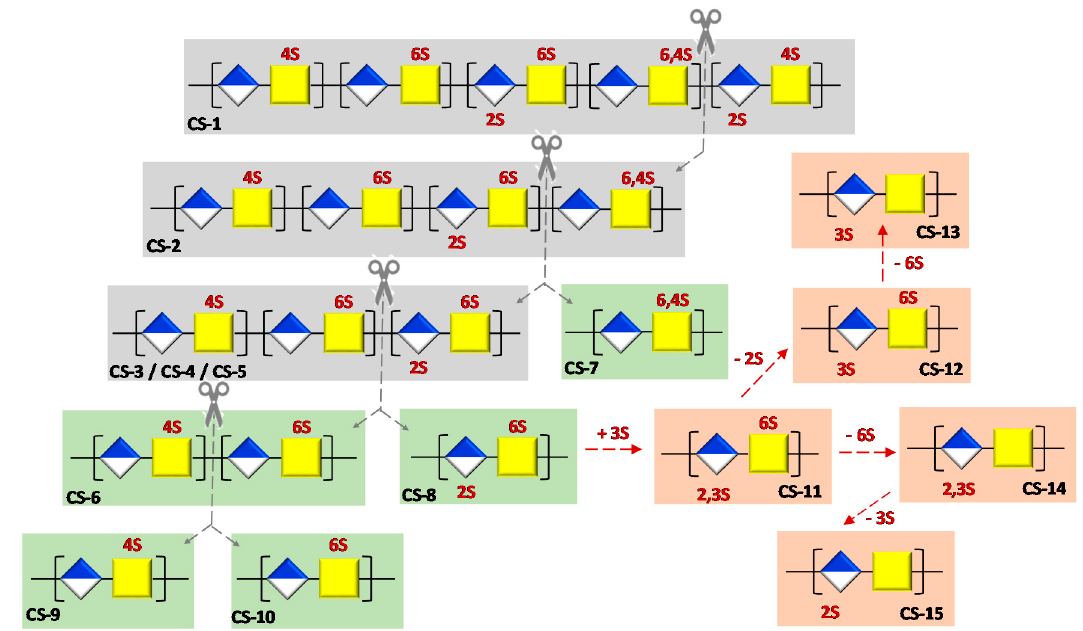
Figure 5. Schematic representation of the polysaccharides systematically analyzed in this study. Natural CSs are highlighted with a grey background. The grey dashed lines indicate differences in terms of disaccharide motifs among natural CSs. These motifs were isolated in the polysaccharides that are highlighted with a green background. Finally, a red background indicates polysaccharides found to recapitulate rare or unnatural sulfation patterns in GlcA. The differences between these polysaccharides are shown over the red dashed arrows.